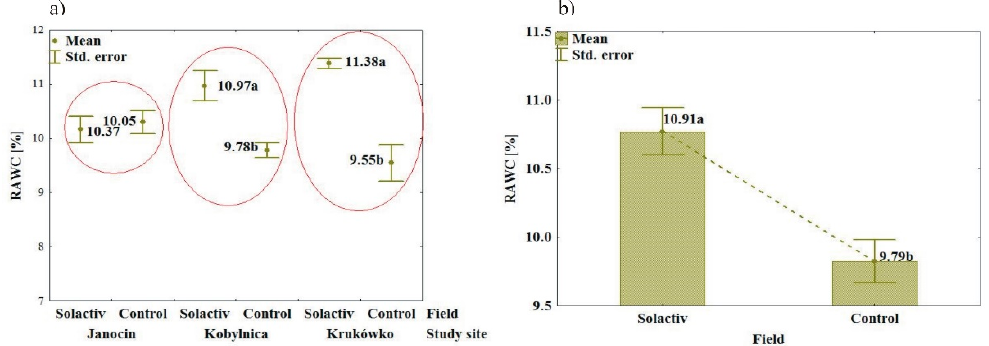
Figure 9. Soil RAWC as affected by the tested conditioner. ( a ) means for individual study sites ( n = 10); ( b ) means for all study sites ( n = 30). Data were analyzed using one-way ANOVA. Mean values for conditioner and control followed by different letters are significantly different at p ≤ 0.05 according to Tukey’s HSD Test. The lack of letters indicates the lack of significance between means.